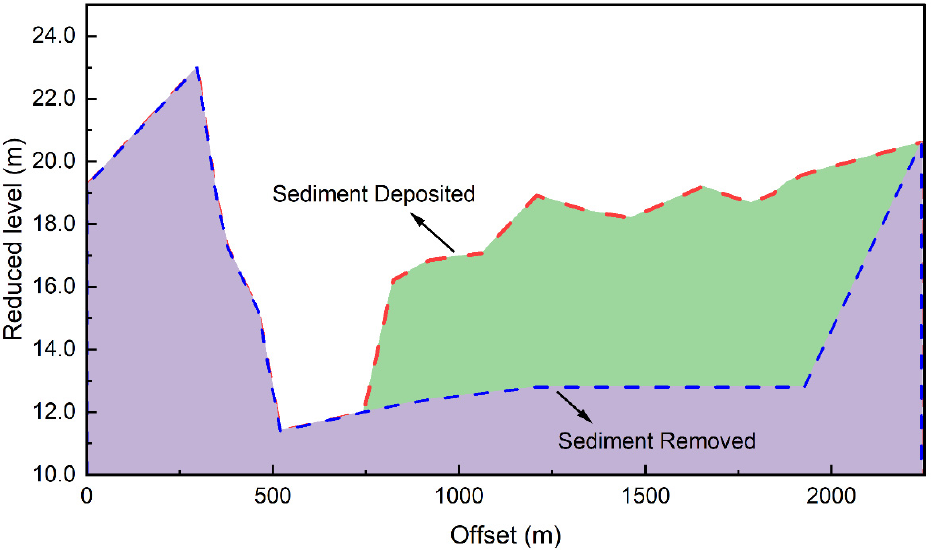
Figure 11. Optimized river geometry for enhancing the flood discharging and flood carrying capacity of the alluvium river-reach.